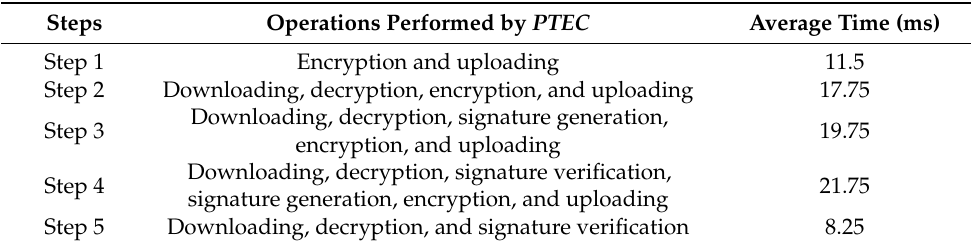
Table 6. The average time of PTEC ’s operations for each step.